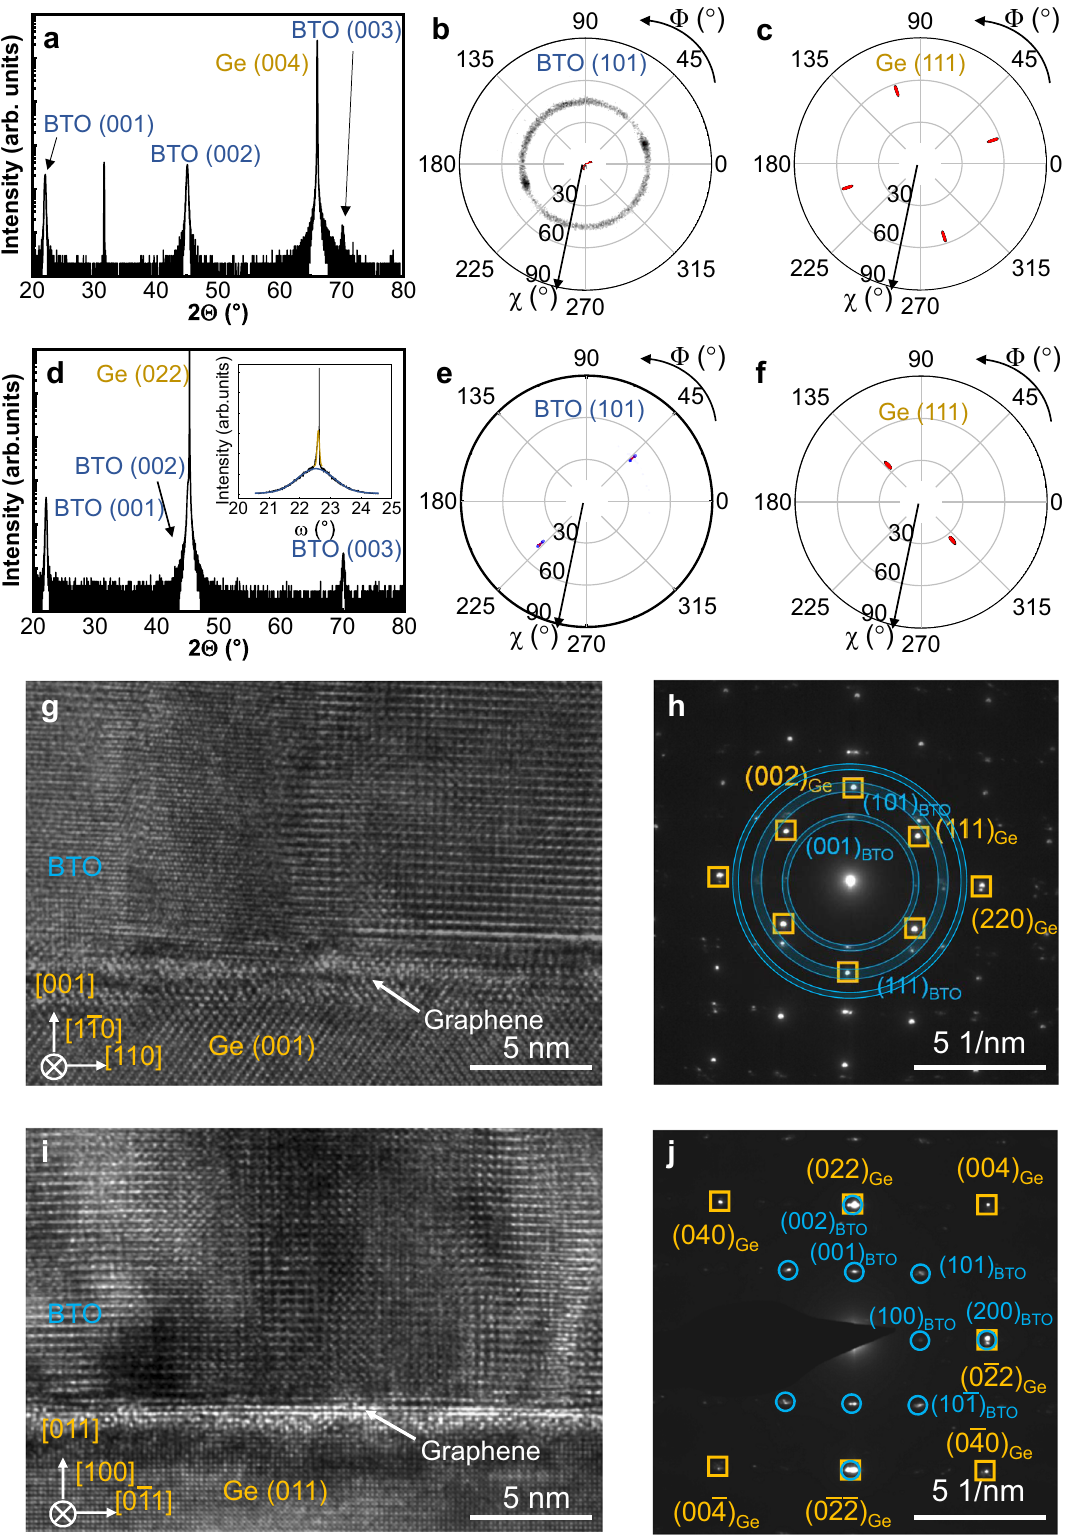
Fig. 2 Crystallographic properties of BTO fi lms on graphene/Ge. XRD results of BTO/graphene/Ge (001) heterostructure: a specular 2 θ scan and pole fi gures using b BTO (101) Bragg conditions and c Ge (111) Bragg conditions. XRD results of BTO/graphene/Ge (011) heterostructure: d specular 2 θ scan and pole fi gures using e BTO (101) Bragg conditions and f Ge (111) Bragg conditions. g Cross-sectional TEM image of the BTO /graphene/Ge (001) heterostructure. h SAED pattern of the sample is shown in g . Orange squares mark Ge diffraction dots while blue rings denote the BTO diffraction dots region. i Cross-sectional TEM image of the BTO/graphene/Ge (011) heterostructure. j SAED pattern of the sample shown in i . Orange squares mark Ge diffraction dots while blue circles denote BTO diffraction